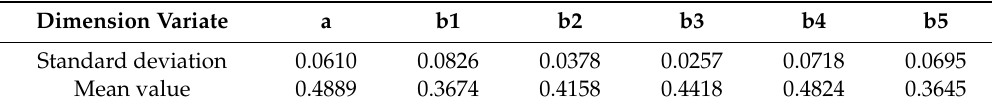
Table 9. The standard deviation and mean value of each dimension